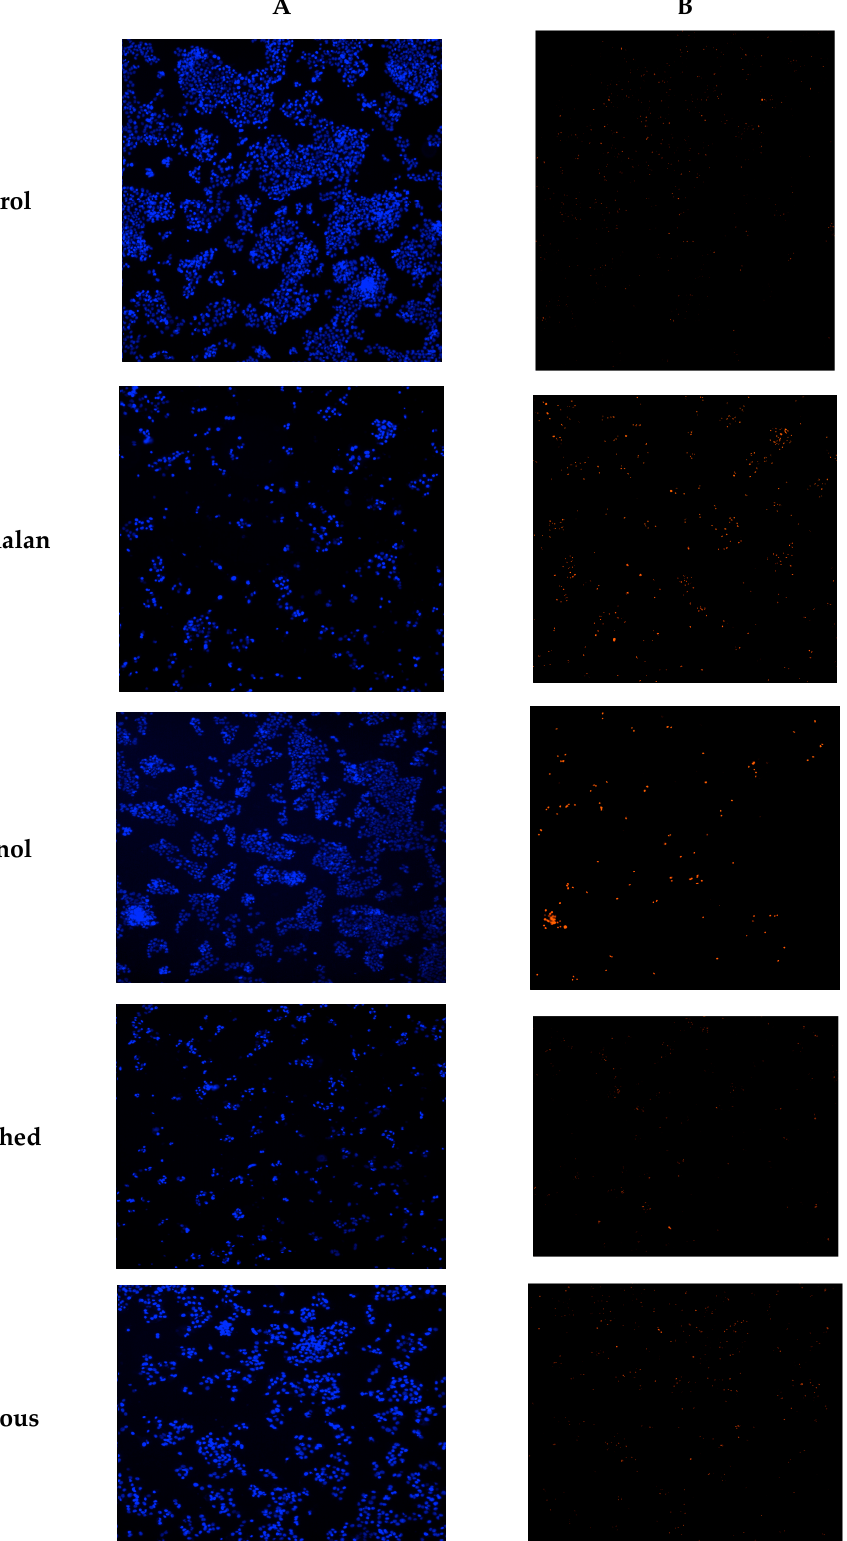
Figure 3. Images of C3A cells after 48 h treatment with 100 µg/mL each of ethanol, blanched and aqueous extracts of H. arborescens leaves obtained from Hoechst 33,342 staining. Column ( A )—all nuclei, Column ( B )—nuclei of dead cells.